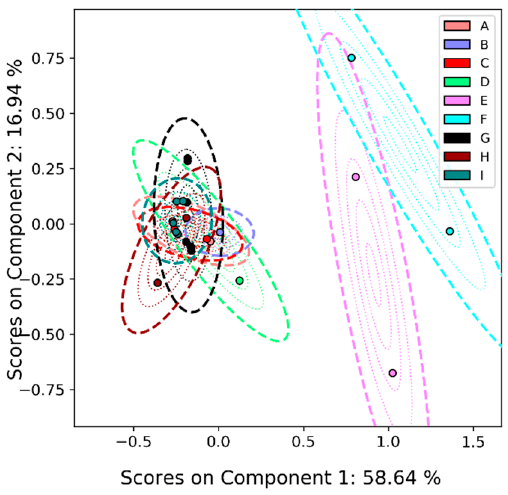
Figure 11. PCA results with uncertainty analysis on the ILS’s GC-MS data using virtual peak